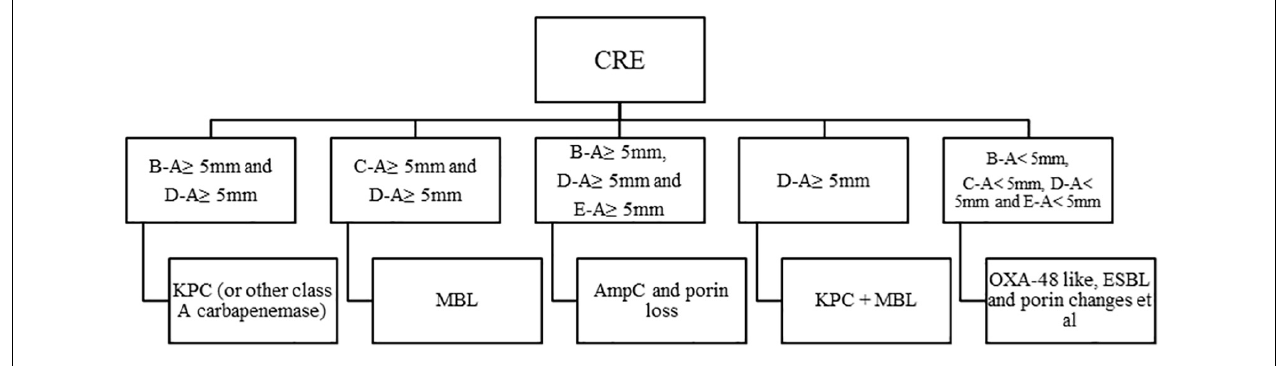
FIGURE 2 | Algorithm for interpretation of results, a 10 µ g imipenem disk was used, in the presence or absence of β - lactamase inhibitors. APBA, 3-aminophenylboronic acid; CLO, cloxacillin; EDTA, ethylenediaminetetraacetic acid; KPC, KPC carbapenemase; MBL, metallo- β -lactamase; ESBL, extended-spectrum β -lactamase. A, imipenem; B, imipenem + APBA; C, imipenem + EDTA; D, imipenem + APBA + EDTA; E, imipenm + CLO.